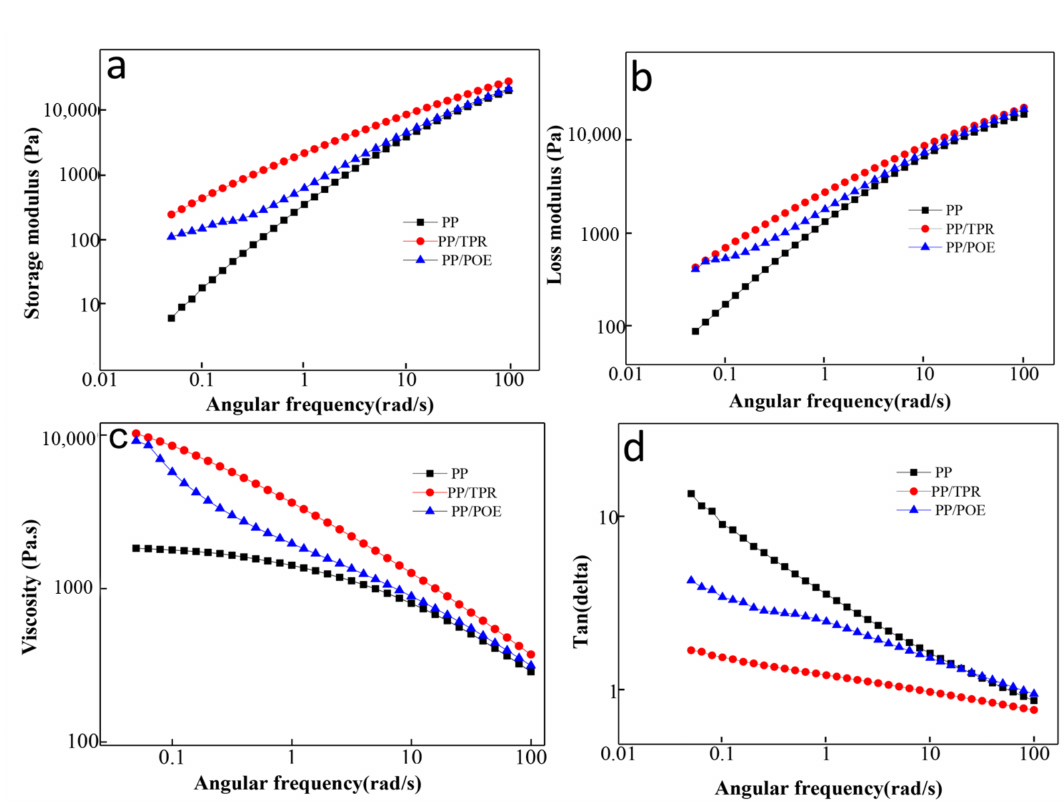
Figure 5. Rheological behavior curves of the PP composites: ( a ) storage modulus, ( b ) loss modulus, ( c ) loss factor, and ( d ) loss